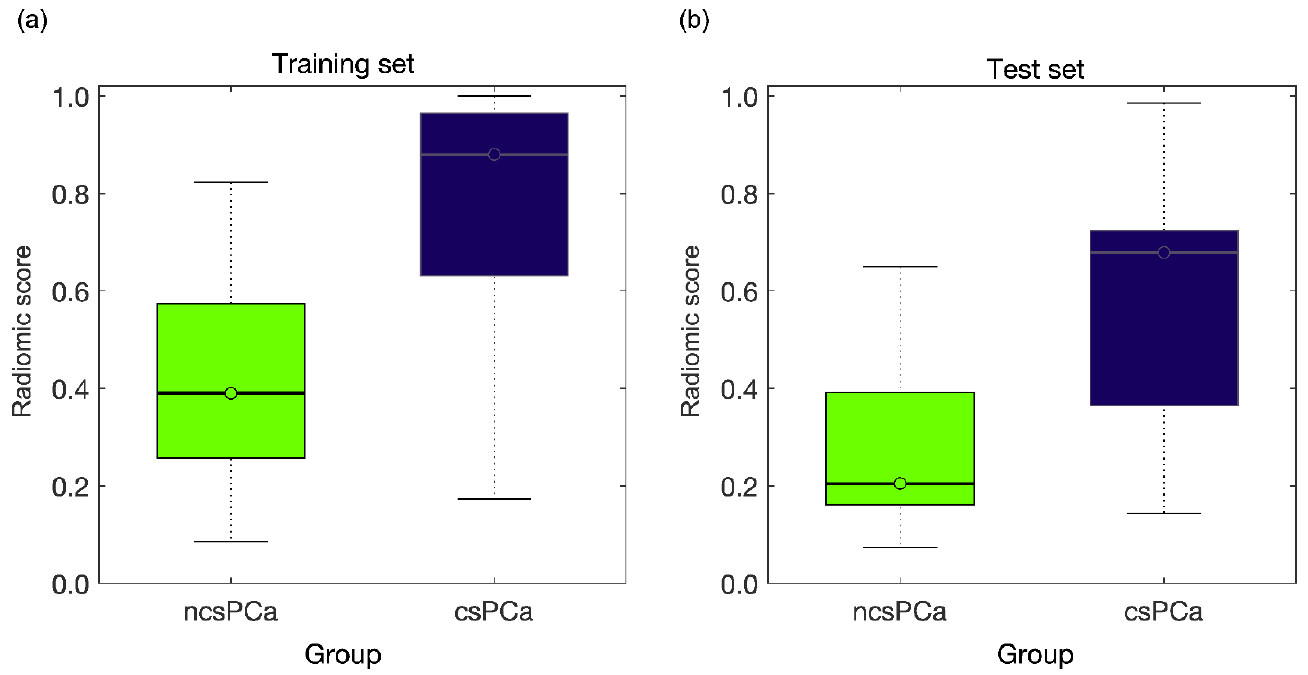
Figure 6. Separation between csPCa and ncsPCa performed by the trained SVM classifier referring to DWI b2000 , with the separation hyperplane highlighted in black.